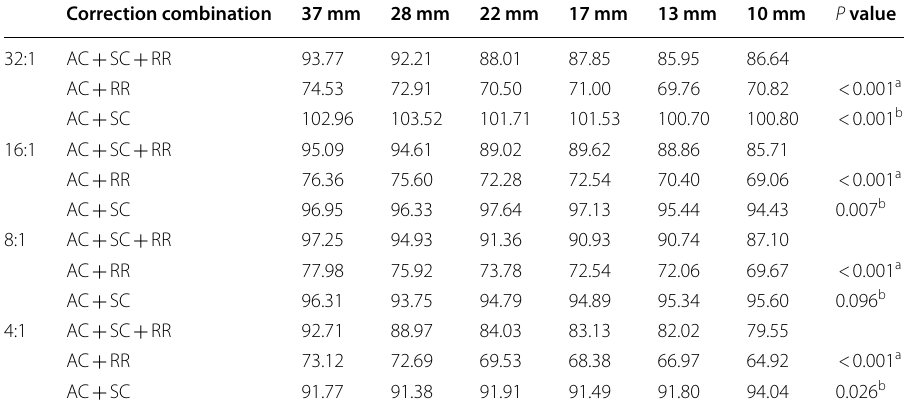
Table 4 Comparison of COVs (Coefficients of variation, %) of all spheres among three different correction combinations